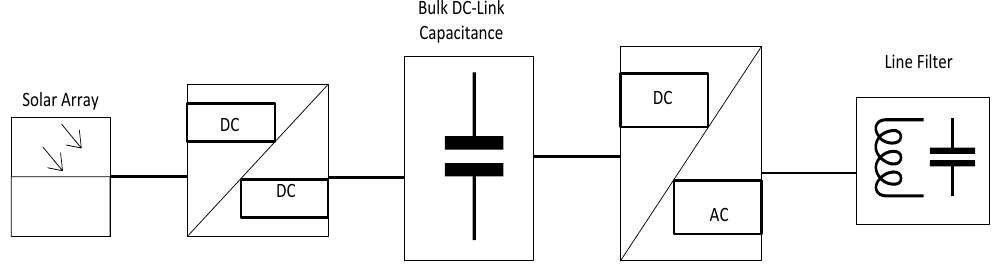
Figure 10. Schematic of one micro-inverter PV System.